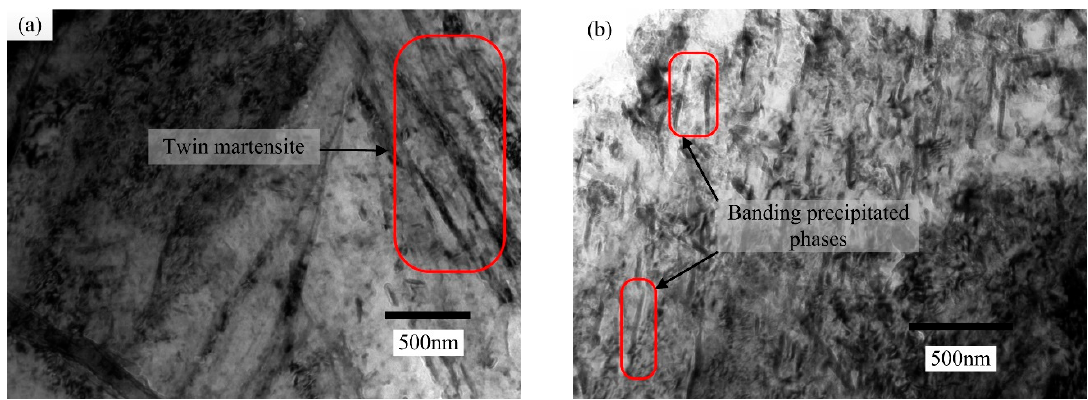
Figure 20. TEM images of the pitch point on the tooth flank of gear 4 ‐ 2: ( a ) twin martensite and ( b ) banding precipitated phases and